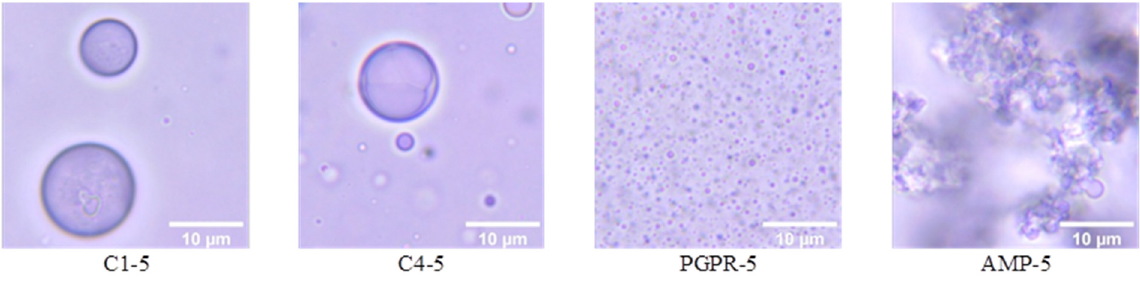
Figure 3. Micrographs of W/O emulsion produced with constant 25% dispersed phase ratio and medium ‐ level emulsifier concentrations (5% for Crill™ 1, Crill™ 4, and PGPR and 2% for AMP).